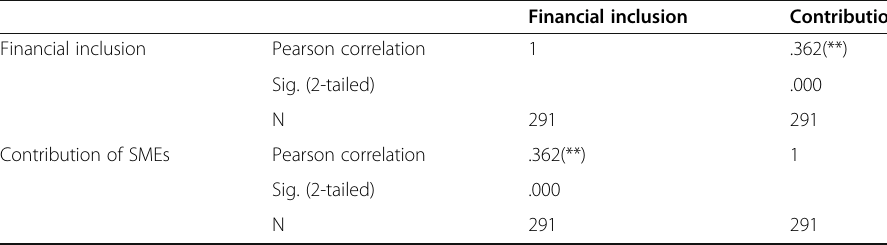
Table 8 Correlation